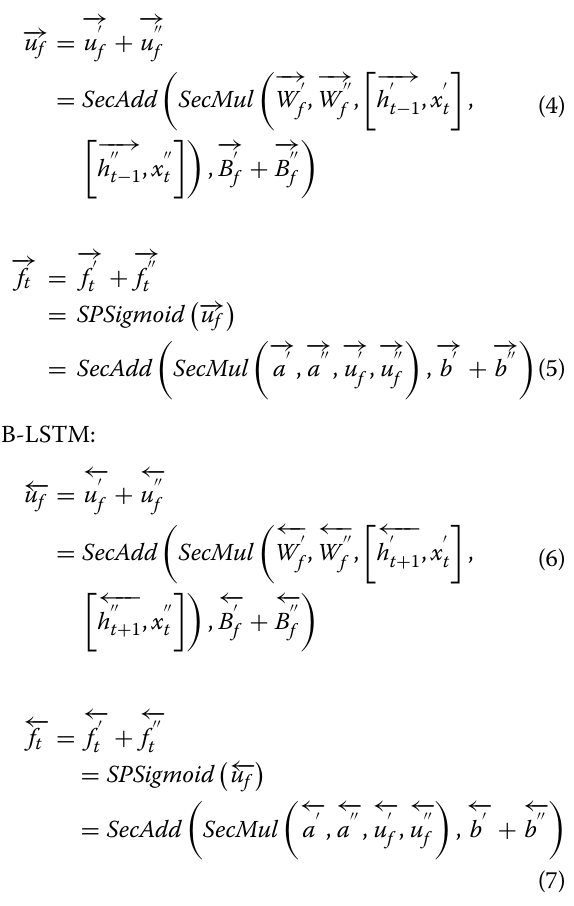
constant term of PSigmoid ( x ) running on S 1 ; a